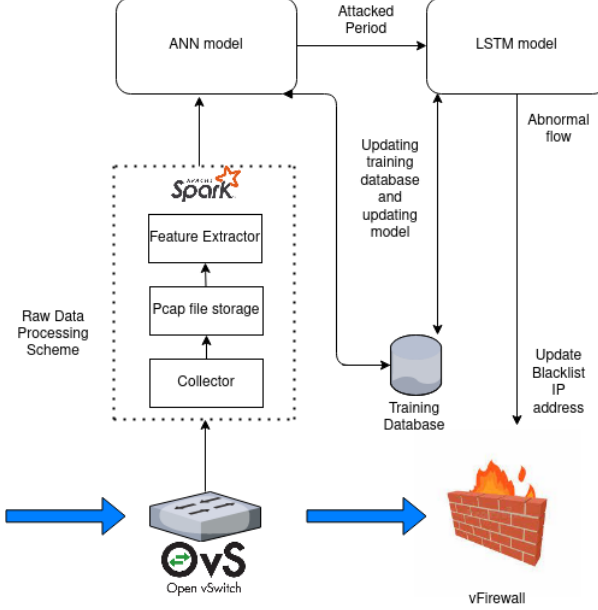
Figure 5. Detailed architecture of the proposed model. Algorithm 1 The two-phase deep learning-based EDoS Defense